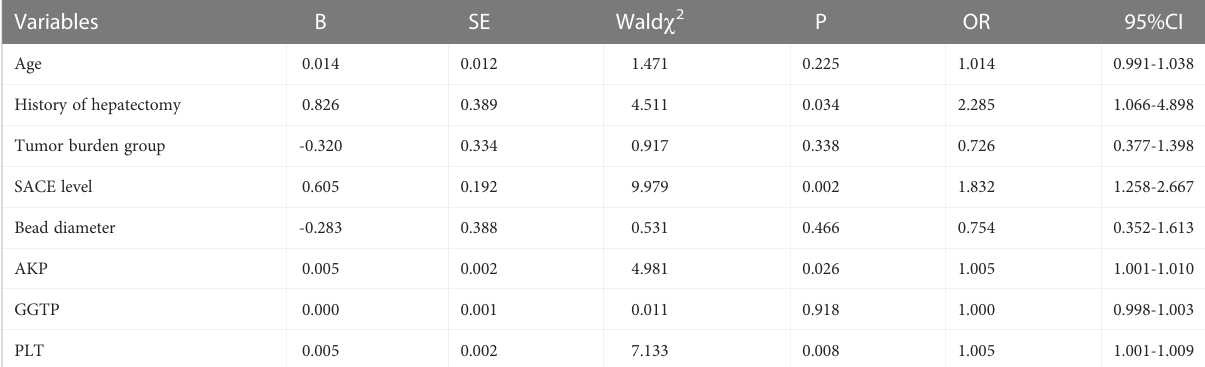
TABLE 2 Results of the multivariate logistic regression analysis.